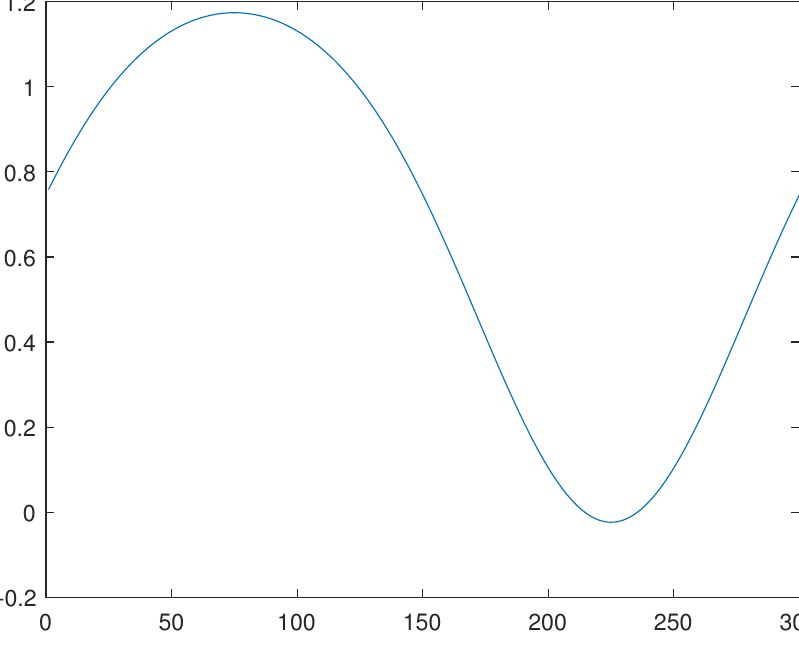
Figure 10. Line 8, solution u 8 ( x ) through the general method of